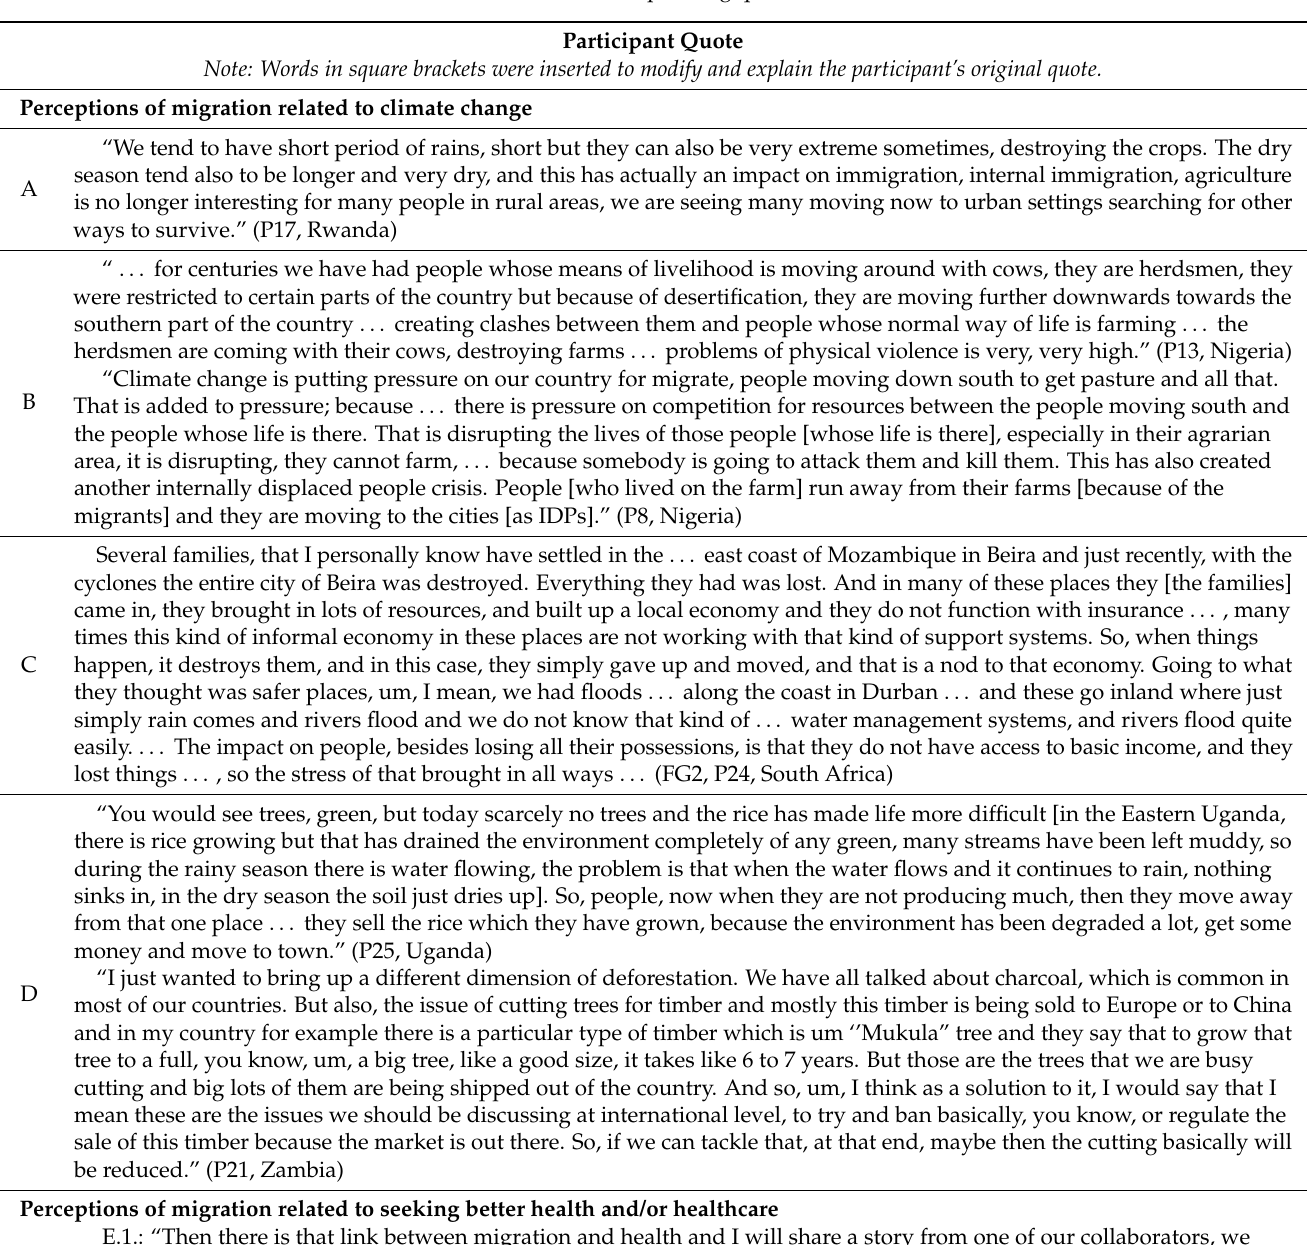
Table 2. Corresponding